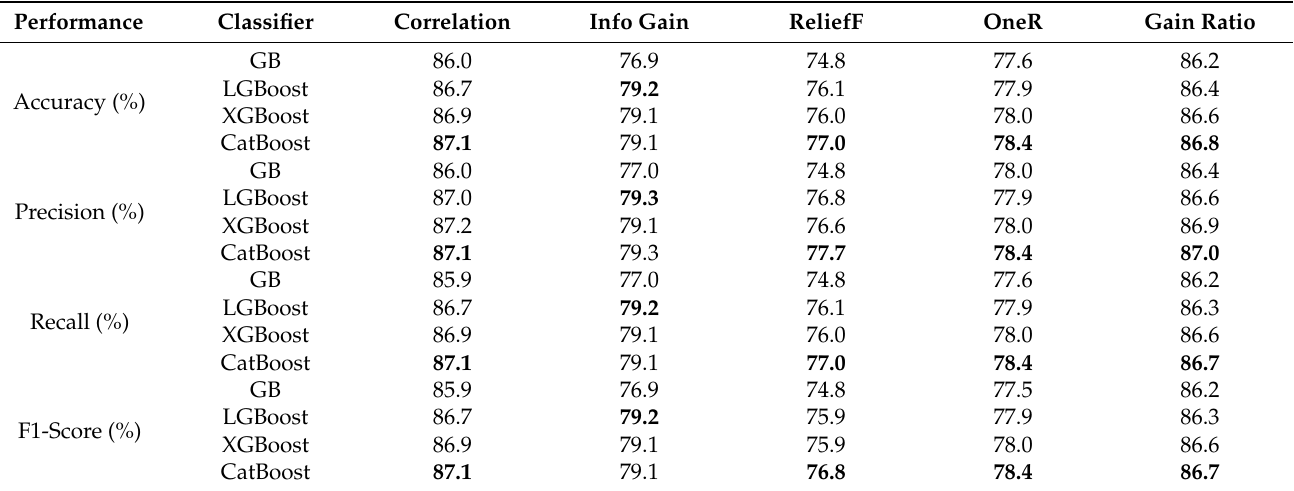
Table 10. Results of the models with respect to K means SMOTE and feature selection techniques.